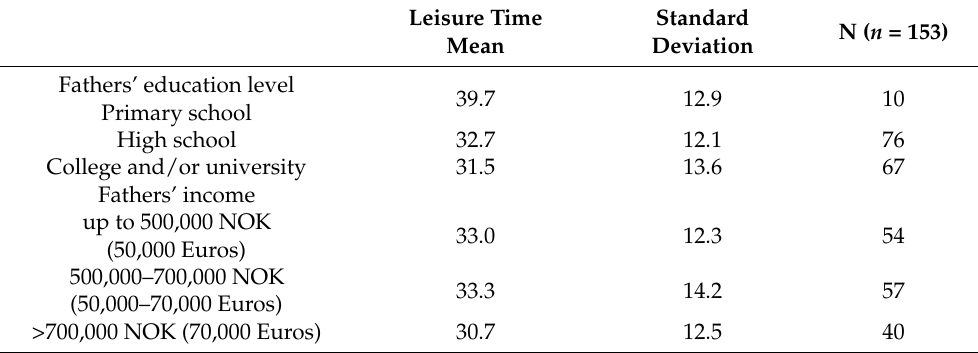
Table 3. Descriptive characteristics of children’s MVPA level at leisure, according to the independent variables: fathers’ education level and annual